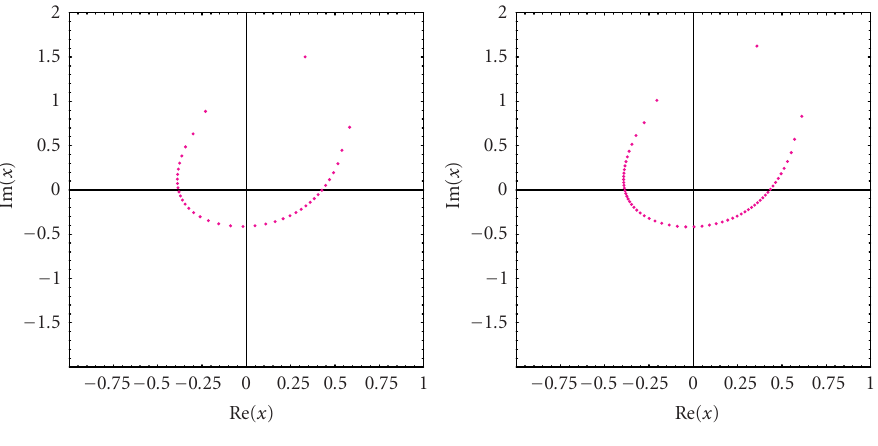
Figure 3.3. Zeros of q -Bernoulli polynomials β m ( x ,1 | − 1 / 2), m = 40,60, and x ∈ C